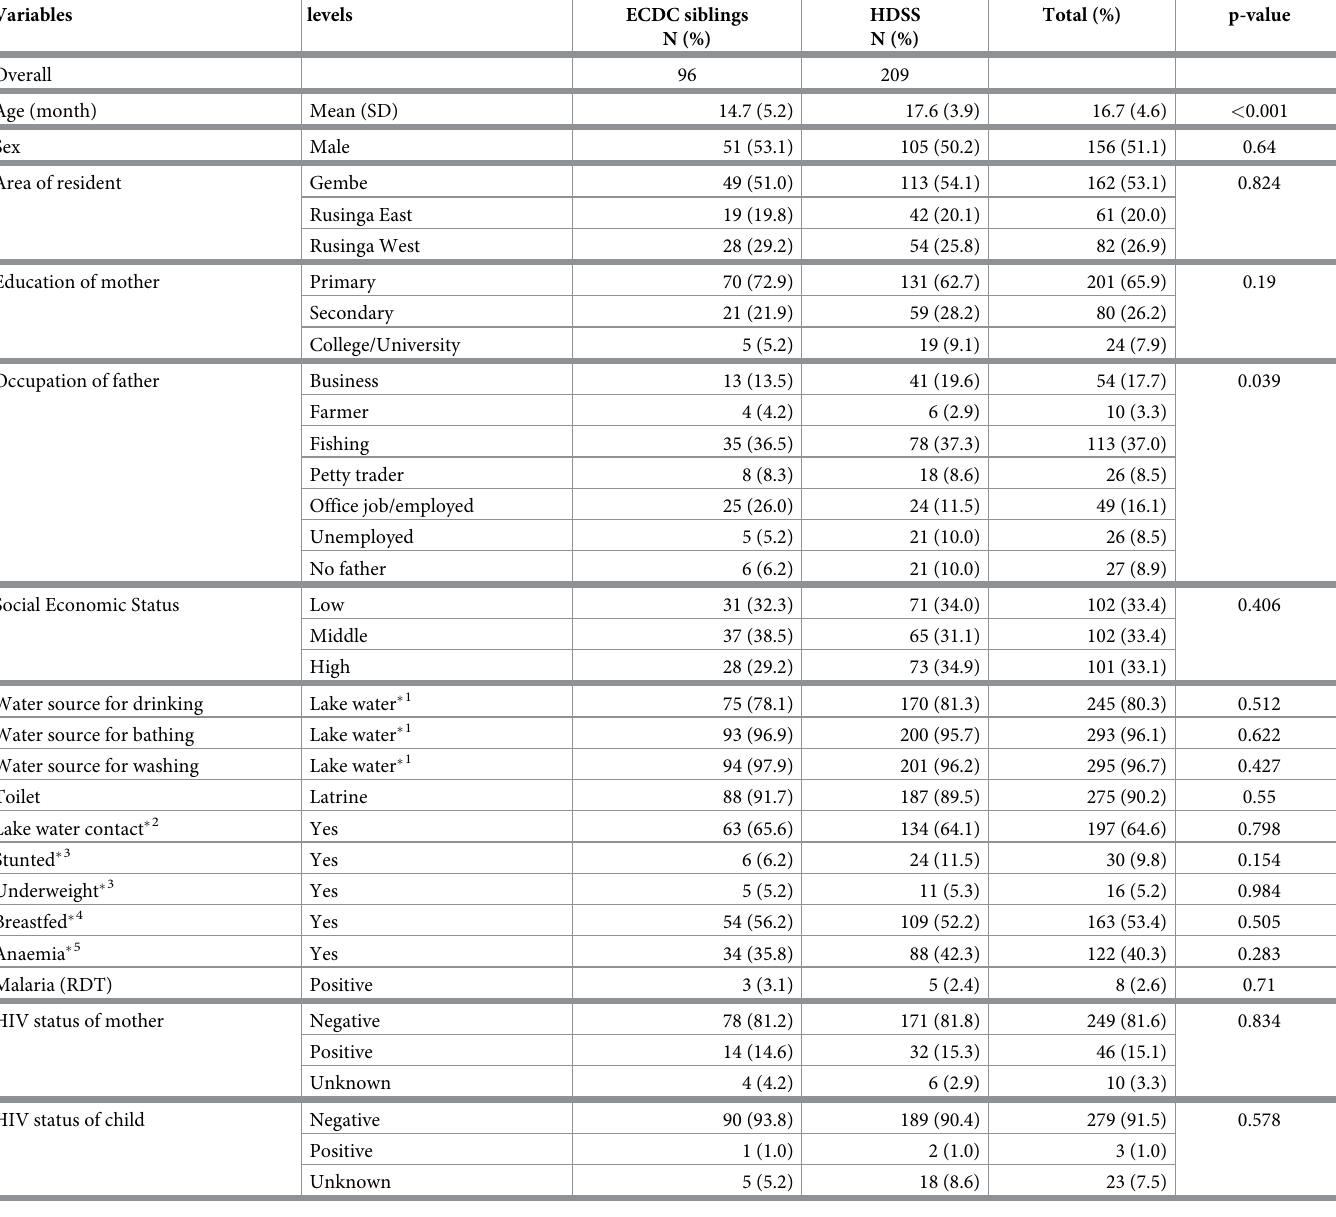
Table 1. Characteristics of study